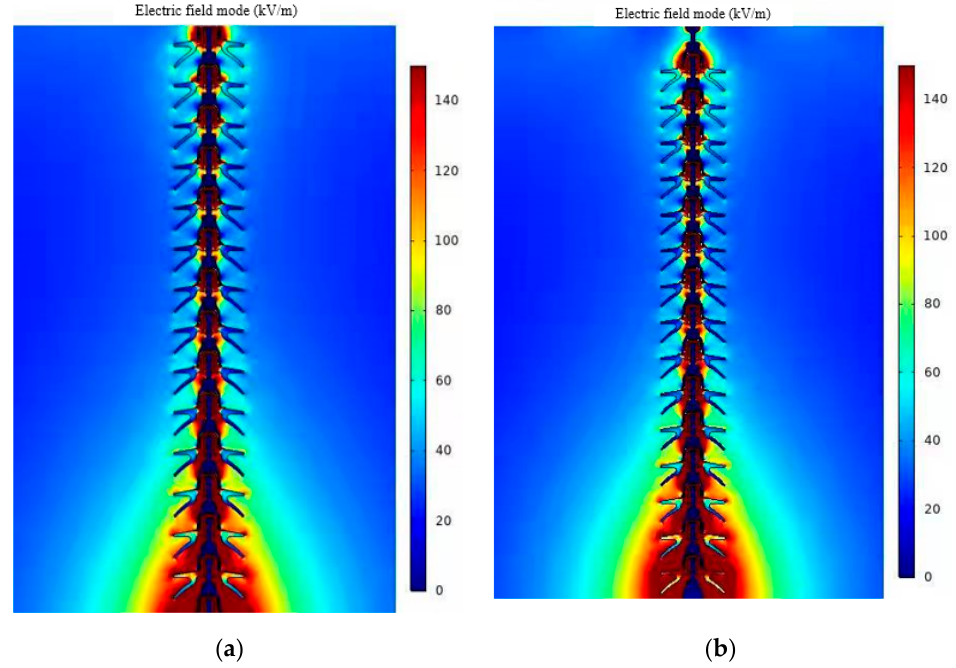
Figure 3. Insulator voltage cloud picture. ( a ) Uncoated insulators. ( b ) Coated insulators.